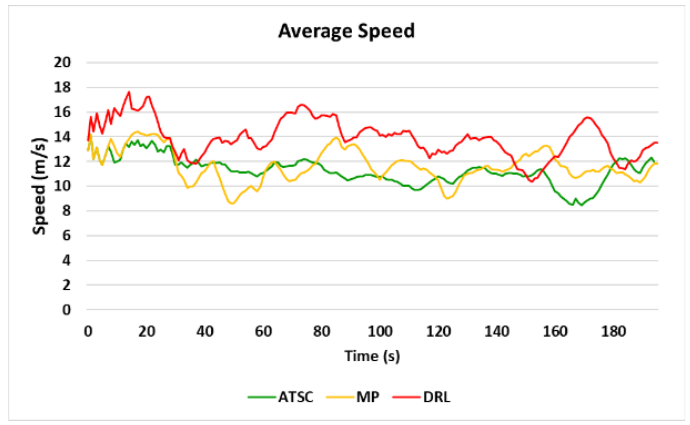
Figure 12. Average speed of 3 scenarios (DRL, ATSC, and MP).